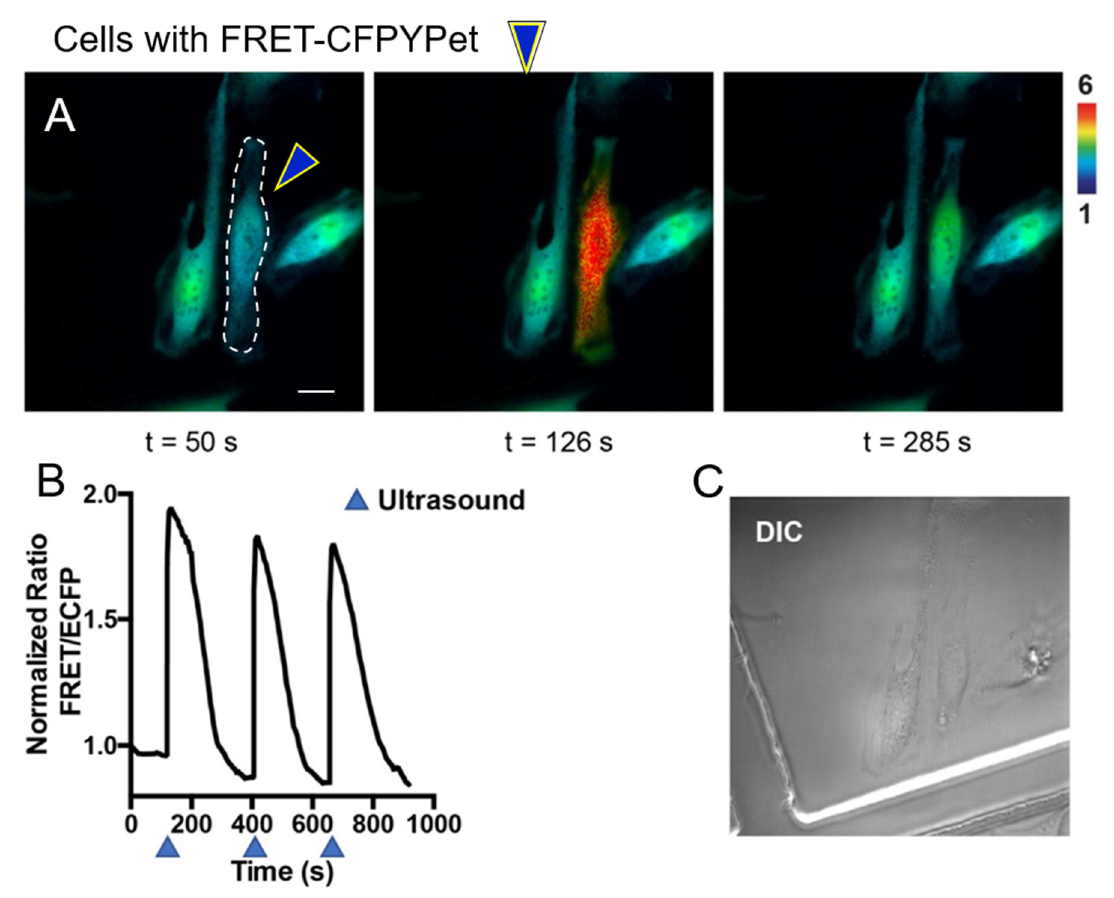
Figure 5. Repeated and transient HFU stimulation. ( A ) Images and ( B ) time course of FRET / ECFP signal ratio of Ca 2+ biosensor show transient and repeated stimulations by high-frequency ultrasound at the target single cell (dashed line in A ). ( B ) High-frequency ultrasound (arrowheads) was applied three times for 5 µs. ( C ) A DIC image of cells in ( A )